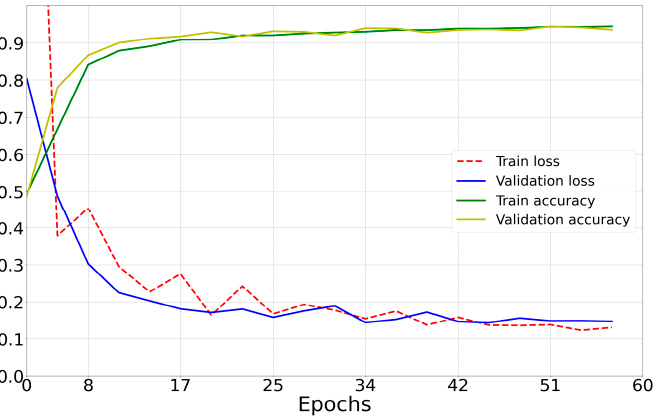
Figure 9. Loss curves of the created model (green and yellow) and accuracy curves (blue and red).